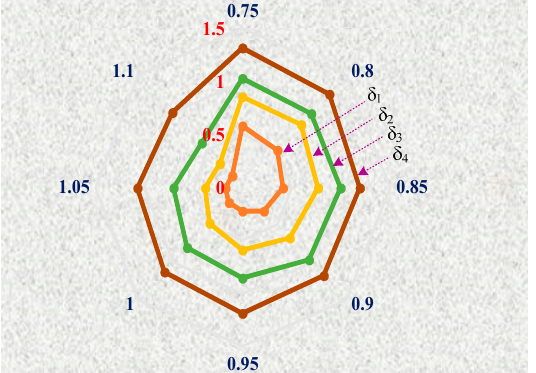
Figure 7. Contour representation of four angles for different modulation indexes (at the end of the third stage).